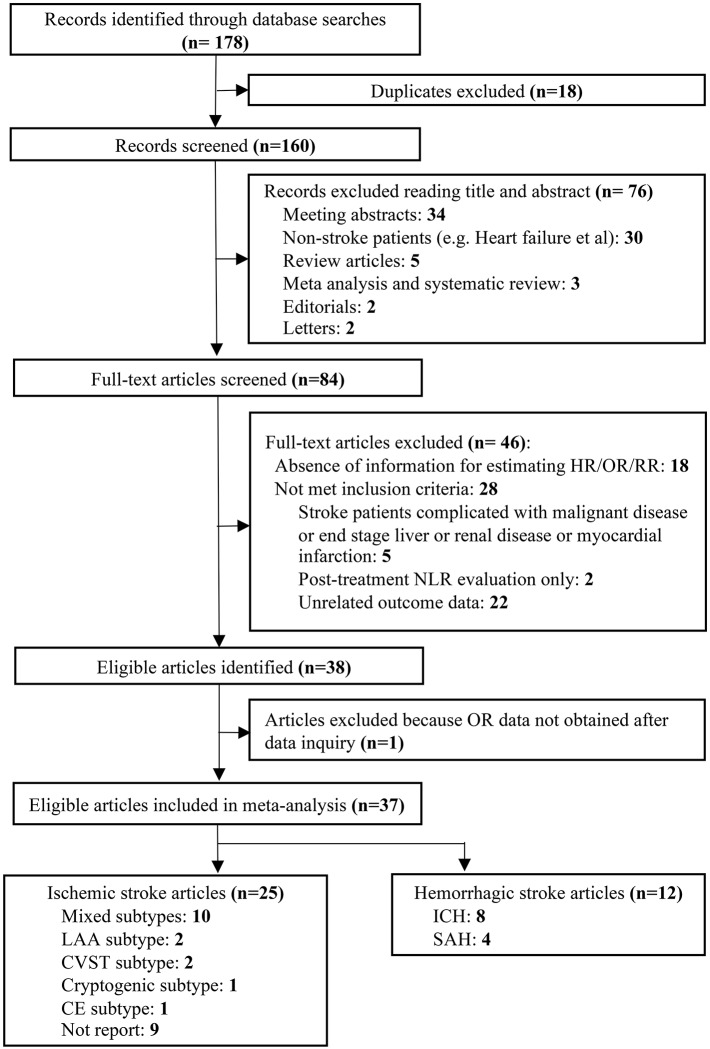
Flow diagram of the study selection process.